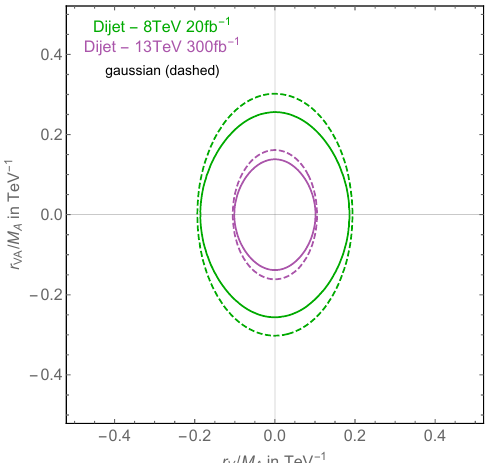
Figure 11 . 95% CL contours for the coe(cid:14)cients r V =M A and r A =M A , in eq. (6.9), extracted from our dijets projections at 8 and 13 TeV. We use S jet , (cid:12)tting only to the central rapidity bin. The allowed region is the one bounded by the lines. The dashed contours are obtained from the Gaussian approximation to the likelihood function, by discarding quadratic terms from eq.